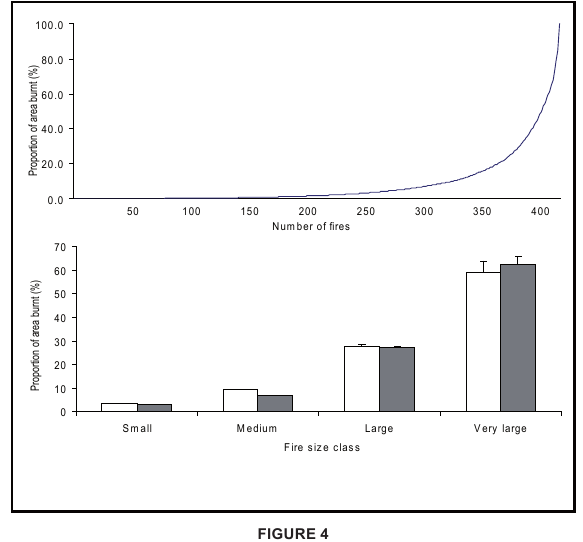
Figure 4 The relationship between fire size and area burnt in the Table Mountain National Park between 1970 and 2007 (upper figure). The proportion of the area burnt in fires of different sizes did not change over time (lower figure). Size classes are small (0–25 ha); moderate (25–100 ha); large (100–500 ha); and very large (> 500 ha). Unshaded and shaded columns are for the periods 1970–1988 and 1989–2007 respectively. Bars are one standard deviation from the mean.